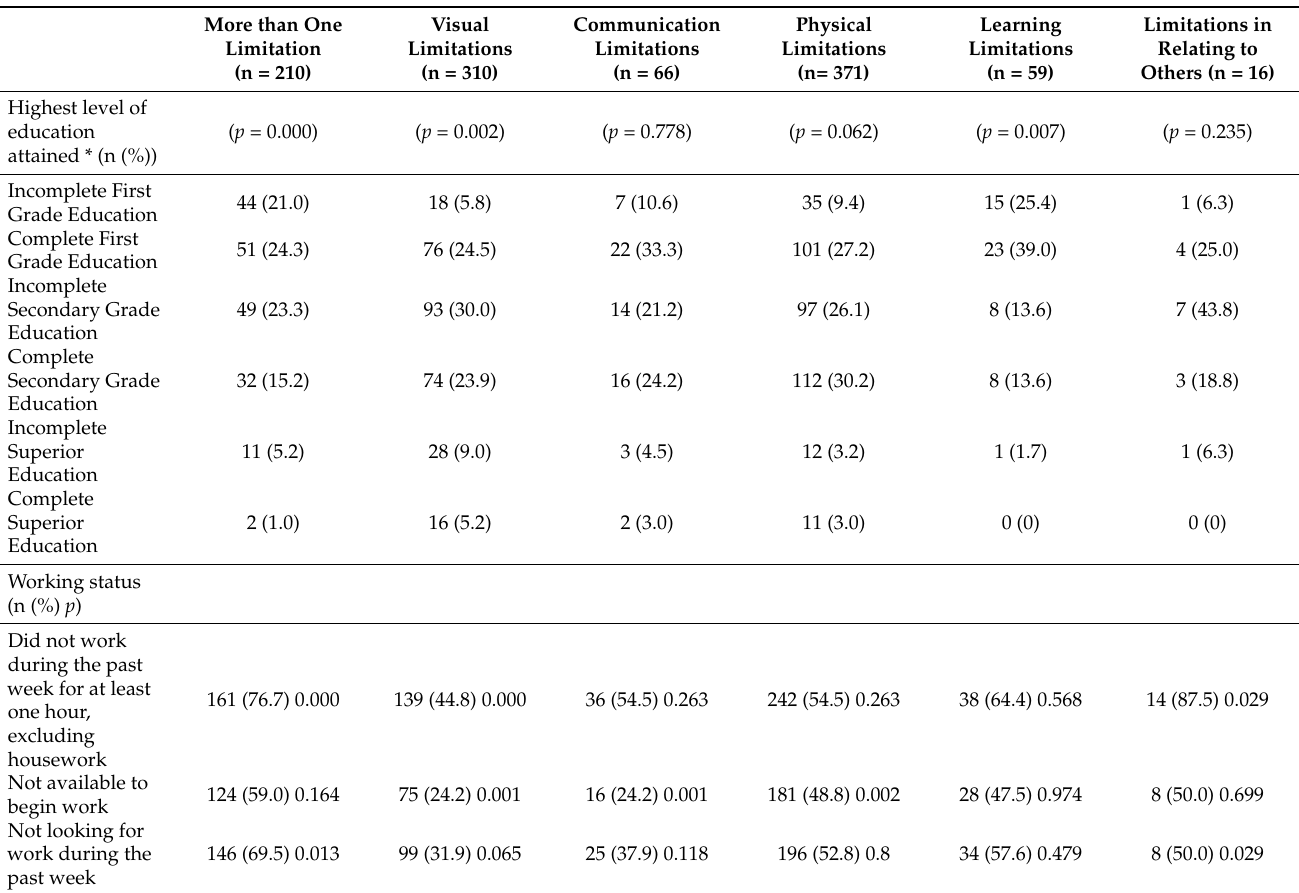
Table 2. Socio-demographic characteristics of the sample according to groups of